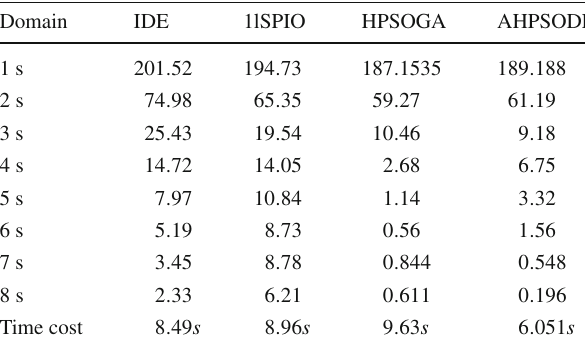
Table 12 Average fitness value for different